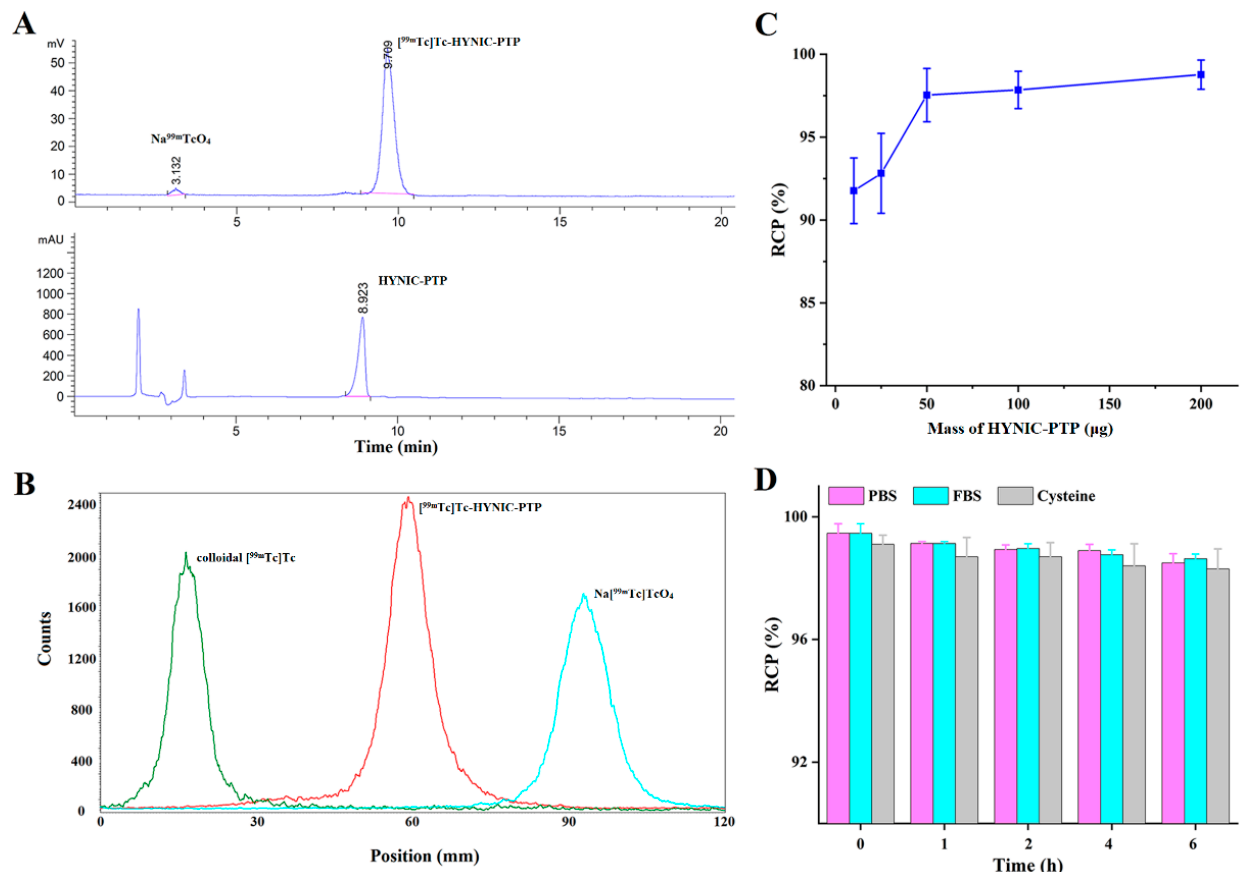
Figure 5. ( A ) Radio-HPLC and ( B ) ITLC results of [ 99m Tc]Tc-HYNIC-PTP. ( C ) RCPs of [ 99m Tc]Tc- HYNIC-PTP at different doses of HYNIC-PTP. ( D ) In vitro stability of [ 99m Tc]Tc-HYNIC-PTP in PBS, FBS, and cysteine solution at different time points.